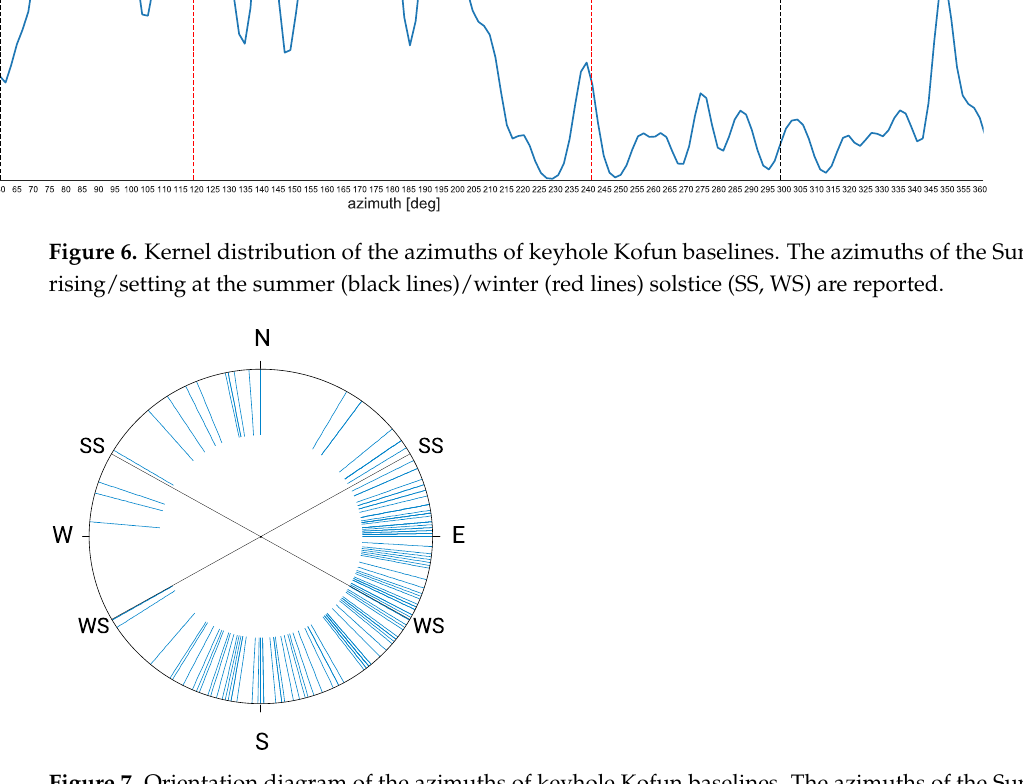
Figure 7. Orientation diagram of the azimuths of keyhole Kofun baselines. The azimuths of the Sun rising/setting at the summer/winter solstice (SS, WS) are reported.